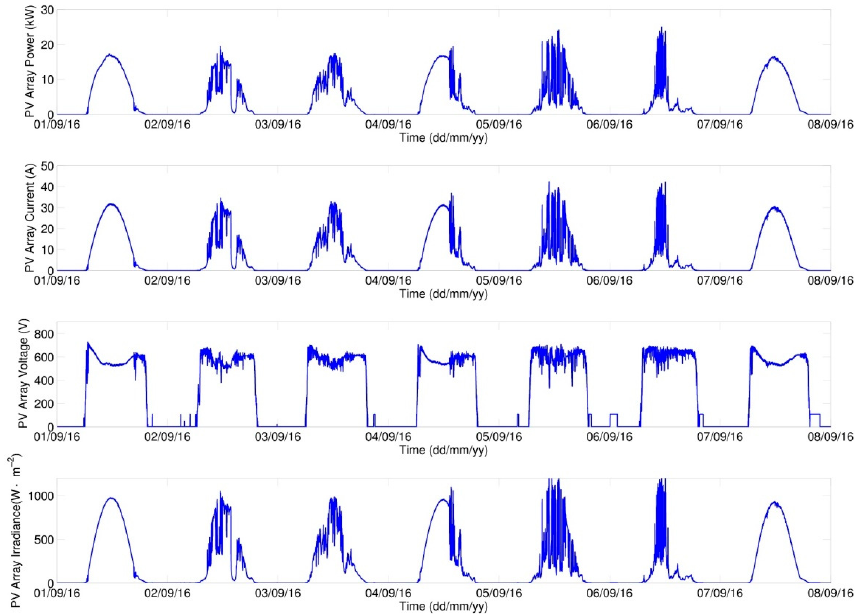
Figure 17. Resulting profiles of simulation of operating states of photovoltaic system (PVS), scenario A.